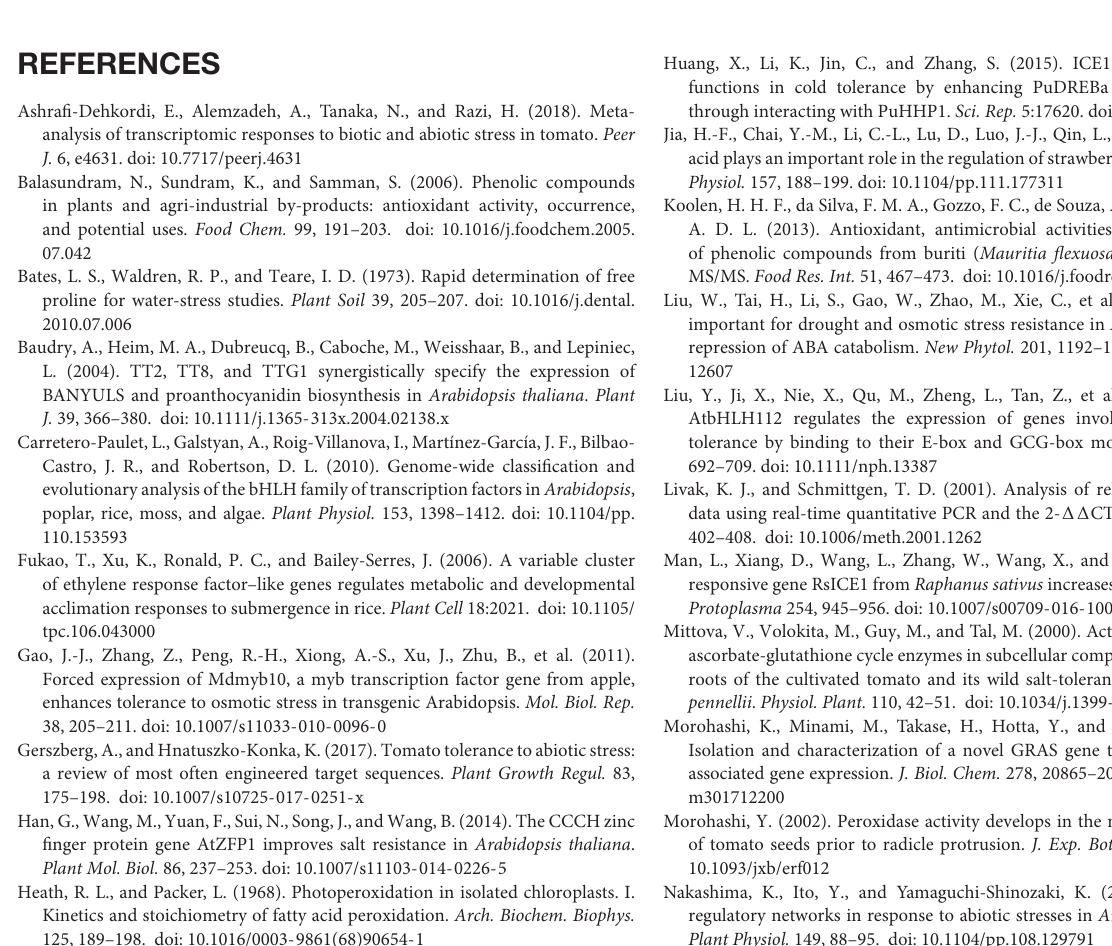
FIGURE S2 | Relative water and chlorophyll content of WT and transgenic line plants under salinity and drought stresses. Relative water content (%), total chlorophyll content during various time points under (A) salinity and (B) drought stresses, respectively. Data represent mean of ± SE for three independent biological replicates ( n = 3) and each replicate contained 15 plants. ∗ and ∗∗ represent the significant difference as determined by t -test ( P -value ≤ 0.01 ∗∗ /0.05 ∗ ). FIGURE S3 | Flavonoid content and expression profile of flavonoid biosynthesis genes in WT and transgenic lines under drought and salinity. Data represent mean of ± SE for three independent biological replicates ( n = 3). ∗ and ∗∗ represent the significant difference as determined by t -test ( P -value ≤ 0.01 ∗∗ /0.05 ∗ ). 1 Expressed in mg quercetin equivalent/g dry weight. FIGURE S4 | Expression profile of ROS scavenging related genes catalase ( SlCAT ) peroxidase ( SlPOD ), superoxide dismutase ( SlSOD ) genes in WT and transgenic lines under drought and salinity. Data represent mean of ± SE for three independent biological replicates ( n = 3). ∗ and ∗∗ represent the significant difference as determined by t -test ( P -value ≤ 0.01 ∗∗ /0.05 ∗ ). FIGURE S5 | Expression profile of proline biosynthesis genes in WT and transgenic lines under drought and salinity. Data represent mean of ± SE for three independent biological replicates ( n = 3). ∗ and ∗∗ represent the significant difference as determined by t -test ( P -value 0.01 ∗∗ /0.05 ∗ ). TABLE S1 | List of primer used in cloning and qRT-PCR for the expression analysis in this